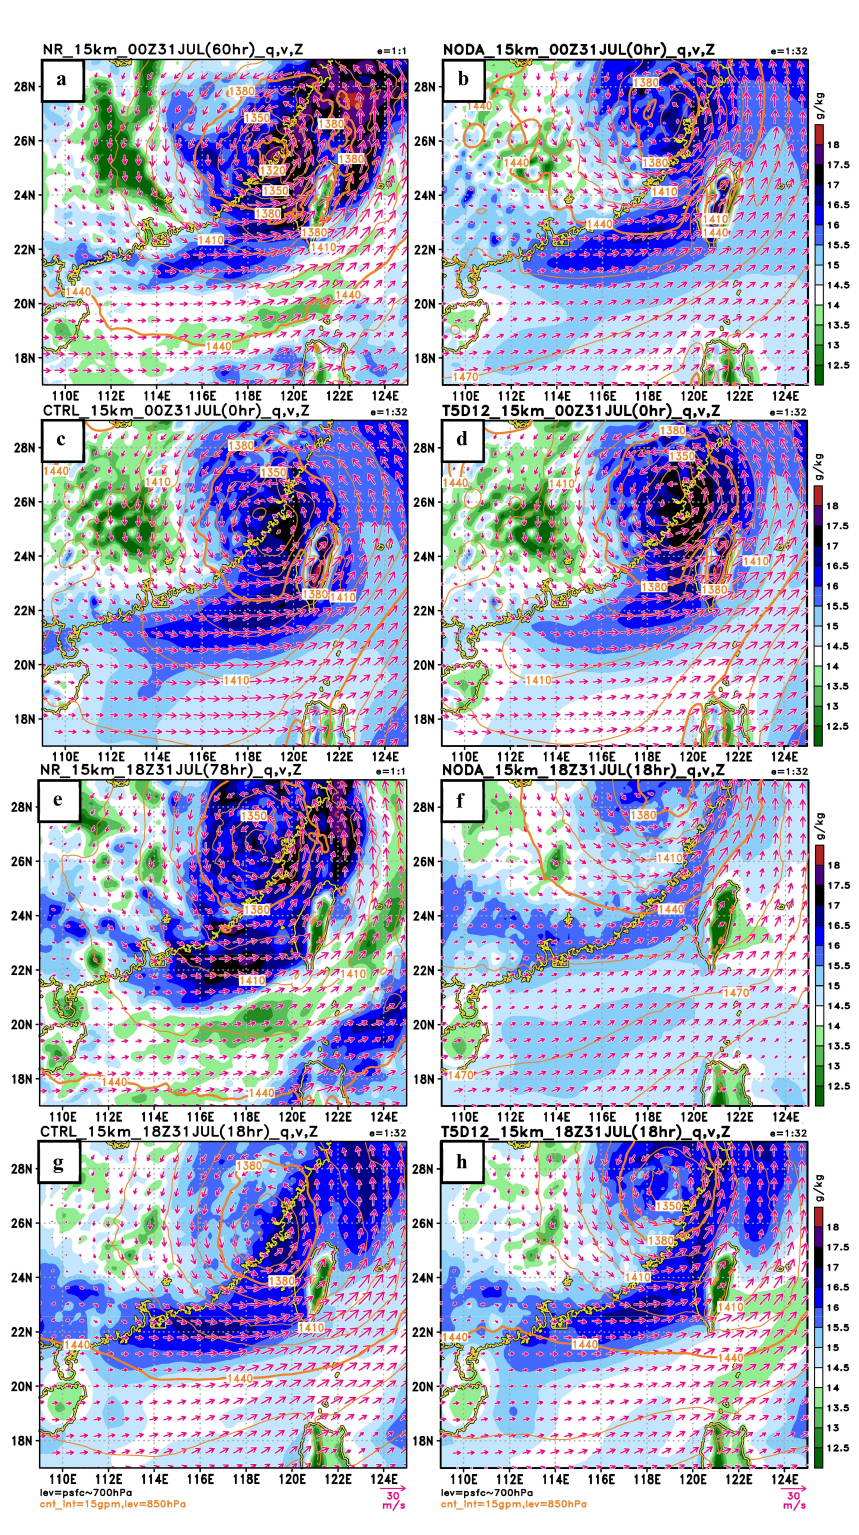
Figure 7. The low-level (surface to 700 hPa) averaged mixing ratio (color shading, g kg − 1 ) and wind (m s − 1 , vector) and 850-hPa geopotential height (contour, interval: 15 gpm) for ( a ) NR and the ensemble mean of ( b ) NODA, ( c ) CTRL, and ( d ) T5D12 at 0000 UTC 31 July 2017. ( e – h ) Same as ( a – d ) but at 1800 UTC 31 July